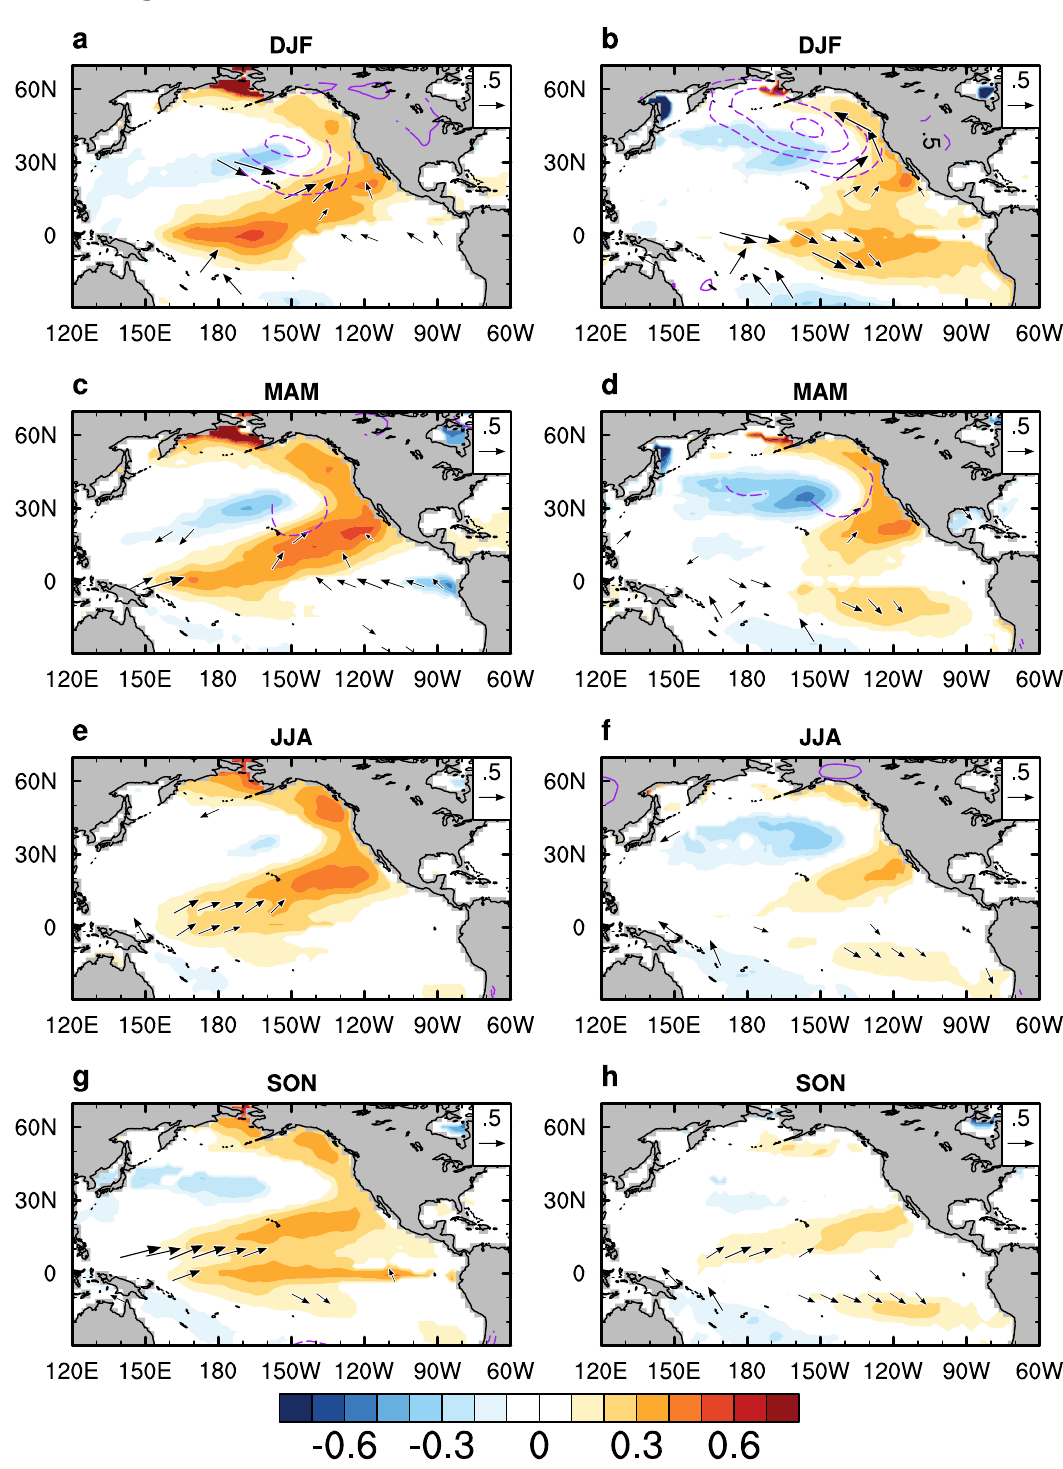
Fig. 3 Sensitivity to the index used for ENSO removal. a , c , e , g Lagged regressions of anomalous SST (°C, shading), surface winds (m s − 1 , vectors), and sea-level pressure (contours, interval of 0.25 hPa) onto the MAM reference PMM index. The individual panels show, from top to bottom, seasonal averages for winter (DJF), spring (MAM), summer (JJA), and fall (SON). Only values signi fi cant at the 95% con fi dence level are shown. b , d , f , h Like ( a , c , e , g ), but for the PMM_CPCT index, for which the ENSO signal is removed more thoroughly prior to analysis. All fi elds are from the NCEP/NCAR